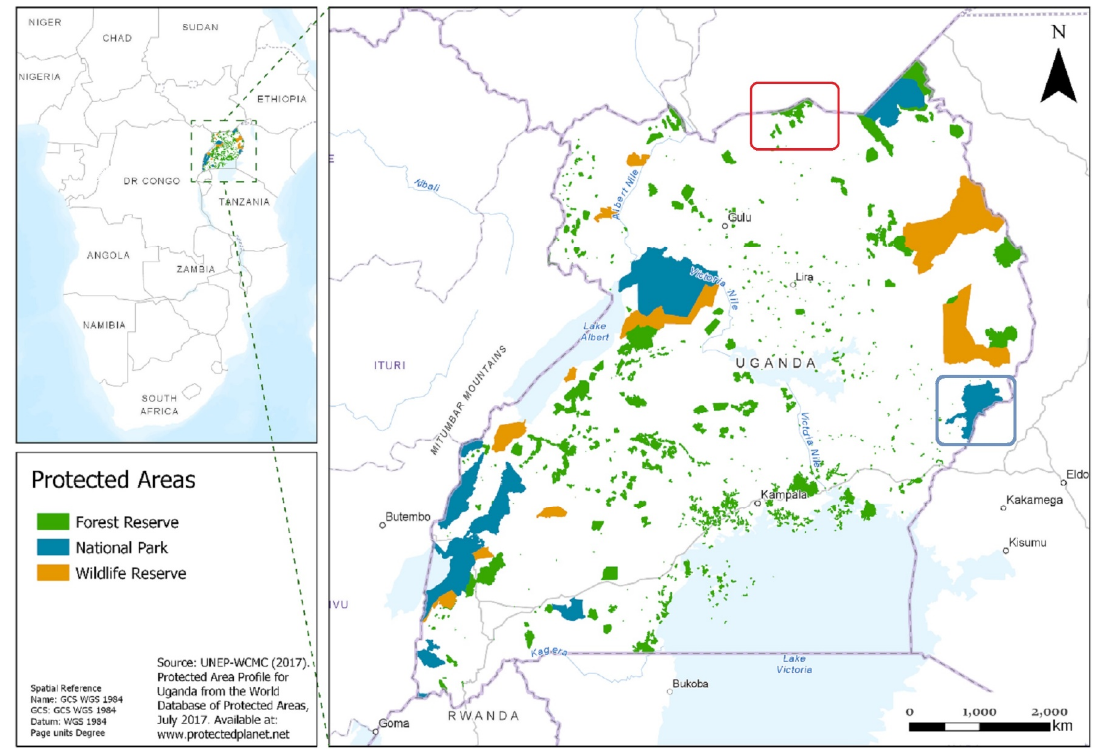
Figure 3. The Agoro-Agu and Mount Elgon Landscapes / study sites. The red square identifies Agoro-Agu, and the blue Mount